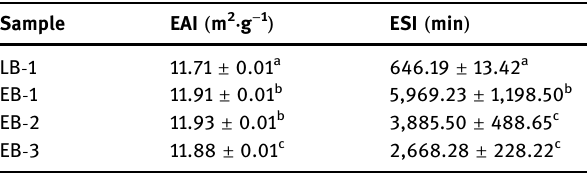
Table 4: Emulsifying properties of enzymatic and alkaline gelatin Sample